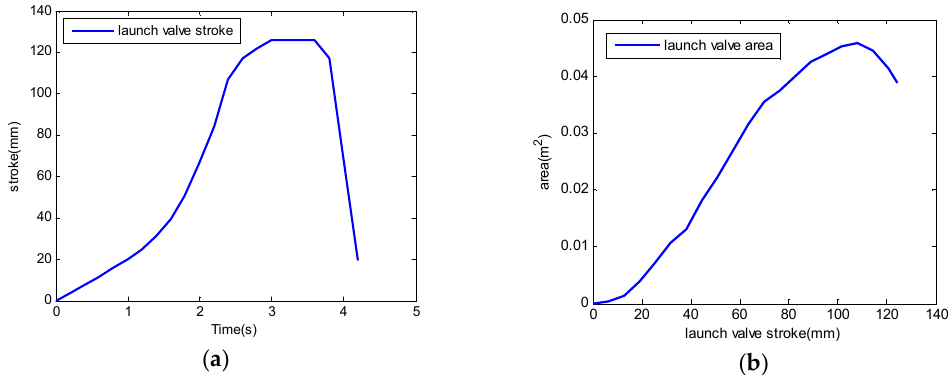
Figure 6. The test data of the stroke of launch valve and effective launch valve opening area: ( a ) Launch valve stroke; ( b ) Effective launch valve opening